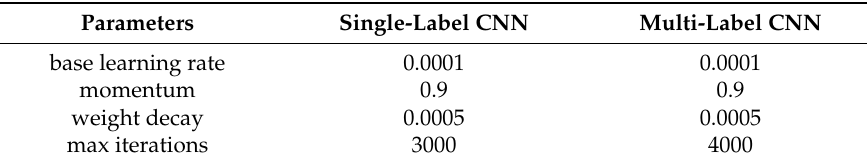
Table 2. Fine-tuning parameters for single-label and multi-label